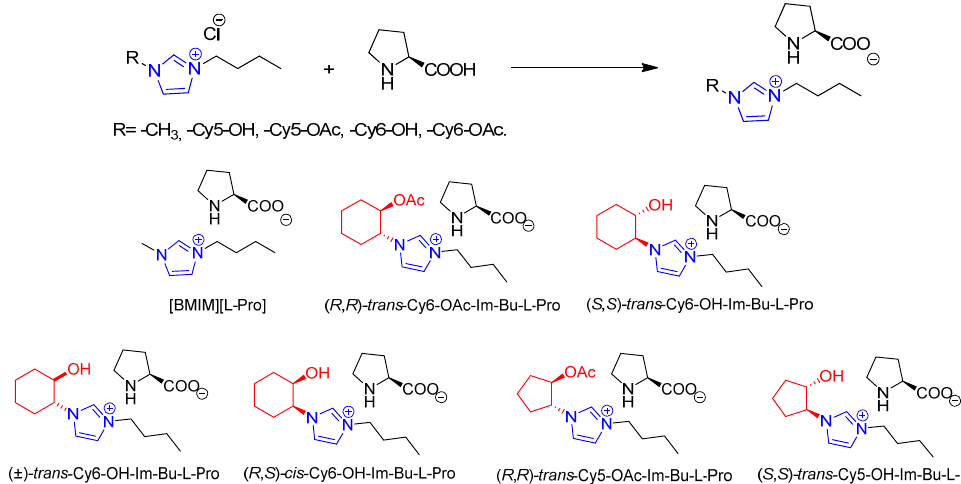
Figure 2. Preparation of chiral imidazolium prolinates through anion metathesis and structures for the CILs studied in this work (only L -prolinates shown).